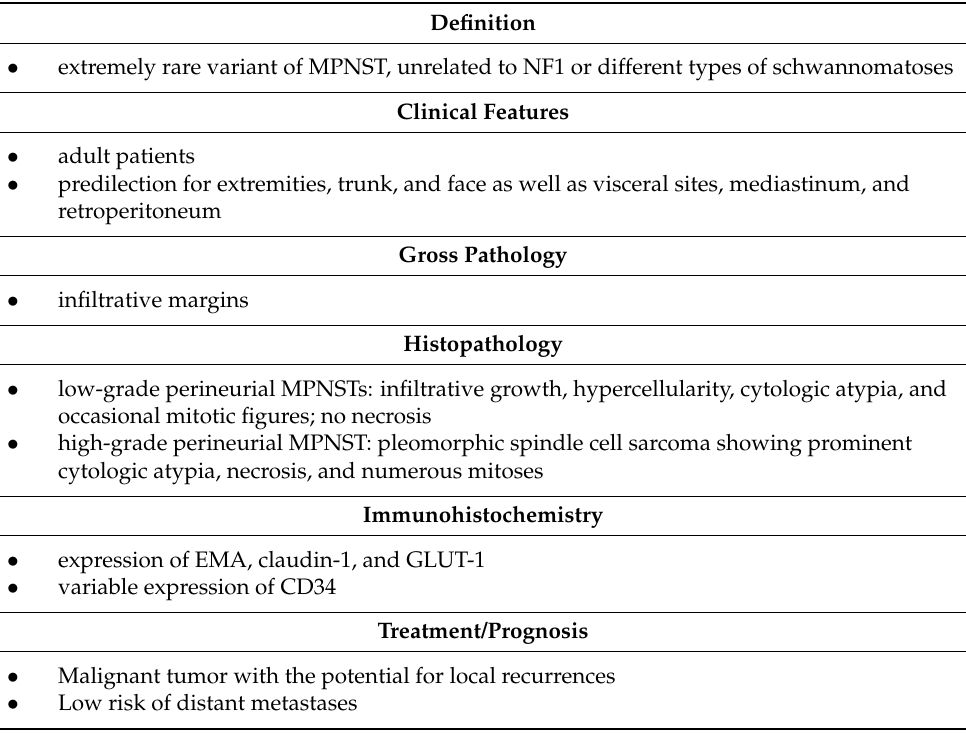
Table 16. Key diagnostic features of perineural MPNST (malignant